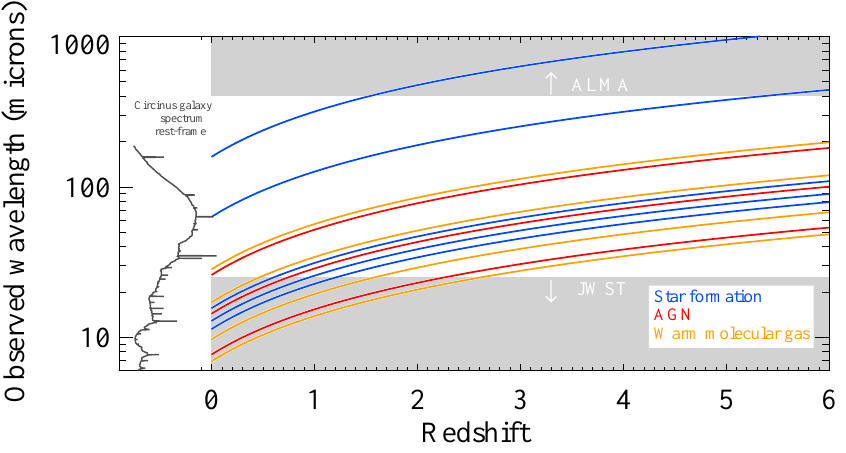
Figure 18. Observed wavelengths of select infrared spectral lines that trace AGN, star formation and warm molecular gas as a function of redshift. The SED of the Circinus galaxy exhibiting these lines is shown tipped on its side at z = 0 on the left panel of the plot. The powerful mid-infrared diagnostics of AGN are shifted into the far-IR for higher redshift galaxies. Currently, there is an order of magnitude gap in our wavelength coverage between JWST and ALMA which could be filled with a future cold far-IR space telescope. Figure adapted from Pope et al. [189], with permission from the